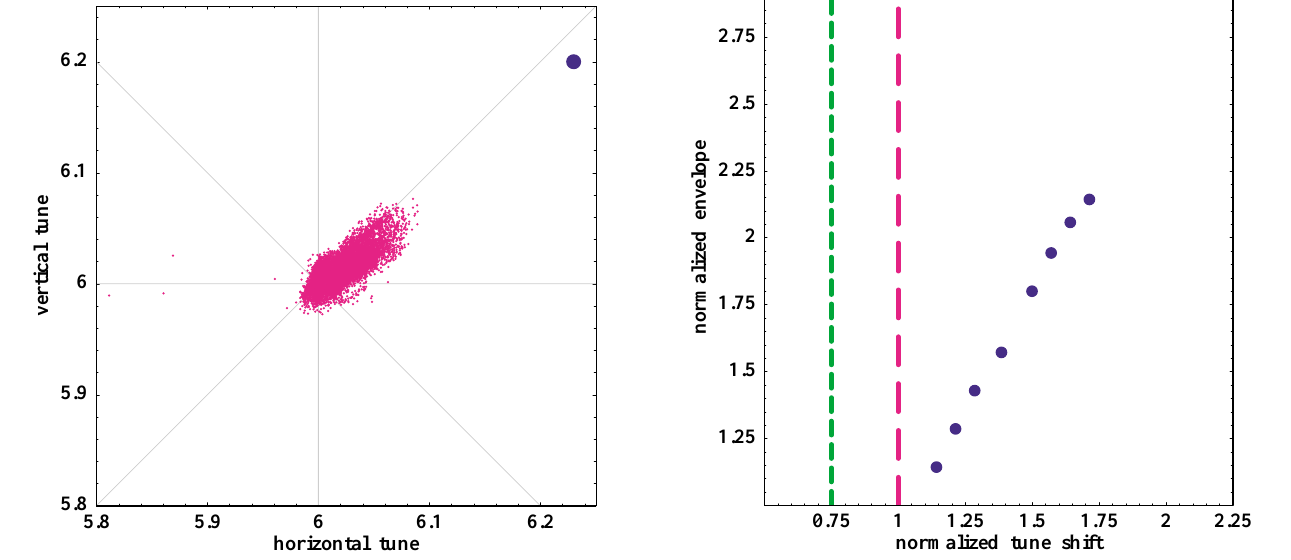
FIG. 9. (Color) Response of the vertical beam envelope to a coherent resonance with harmonic n (cid:1) 12 . PIC simulations for the SNS lattice using WB beam